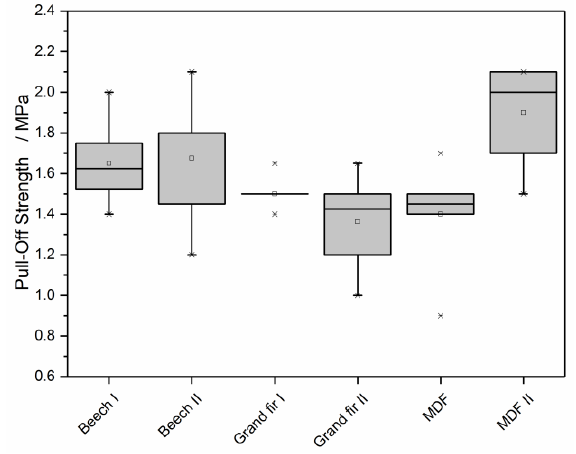
Figure 7. Pull-off strength of single and double-coated European beech, Grand fir and MDF ( N = 10).